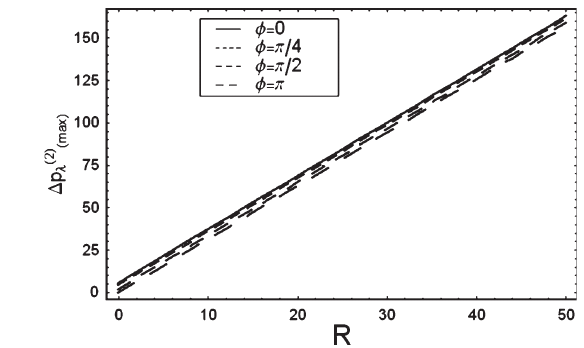
Fig. 8. Effect of Deborah number (cid:15) on variation of (cid:16)p (2) d for a = 0 . 3, b = 0 . 2, θ = − 0 . 001, Re = 10, β = 0 . 1, Fr = 1, sin α = 0 . 2 and φ = π/ 2.